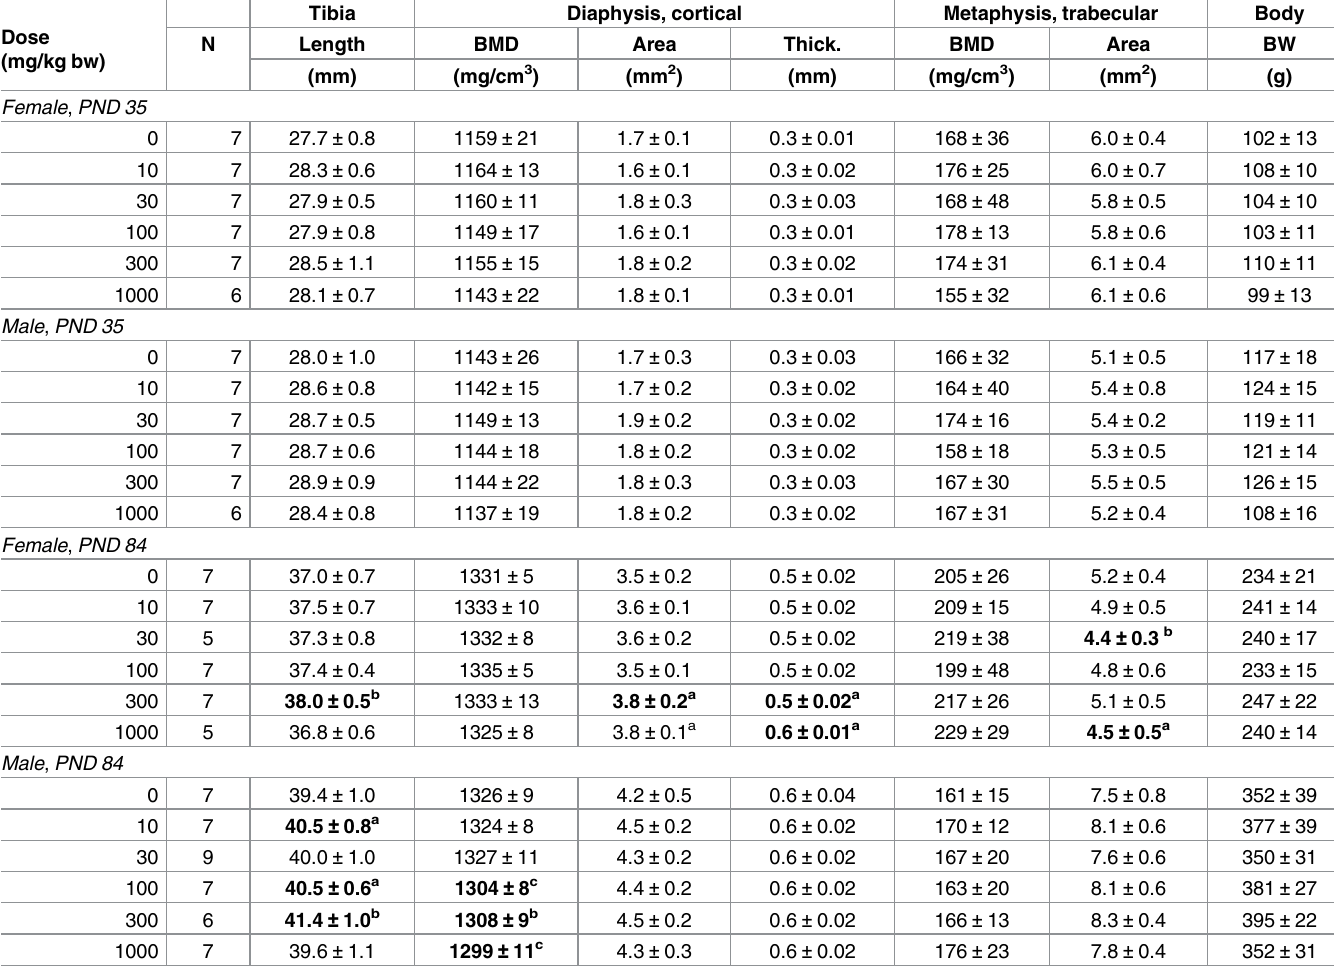
Table 1. Measurements of tibial length (mean ± SD, mm), bone mineral density (mean ± SD, mg/cm 3) , area and thickness (mean ± SD, mm) of diaphyseal cortical and metaphysealtrabecular bone by total dose of PCB 180 and sampling time point. Bodyweights at PND 35 and PND 84 (mean ± SD, g) are also